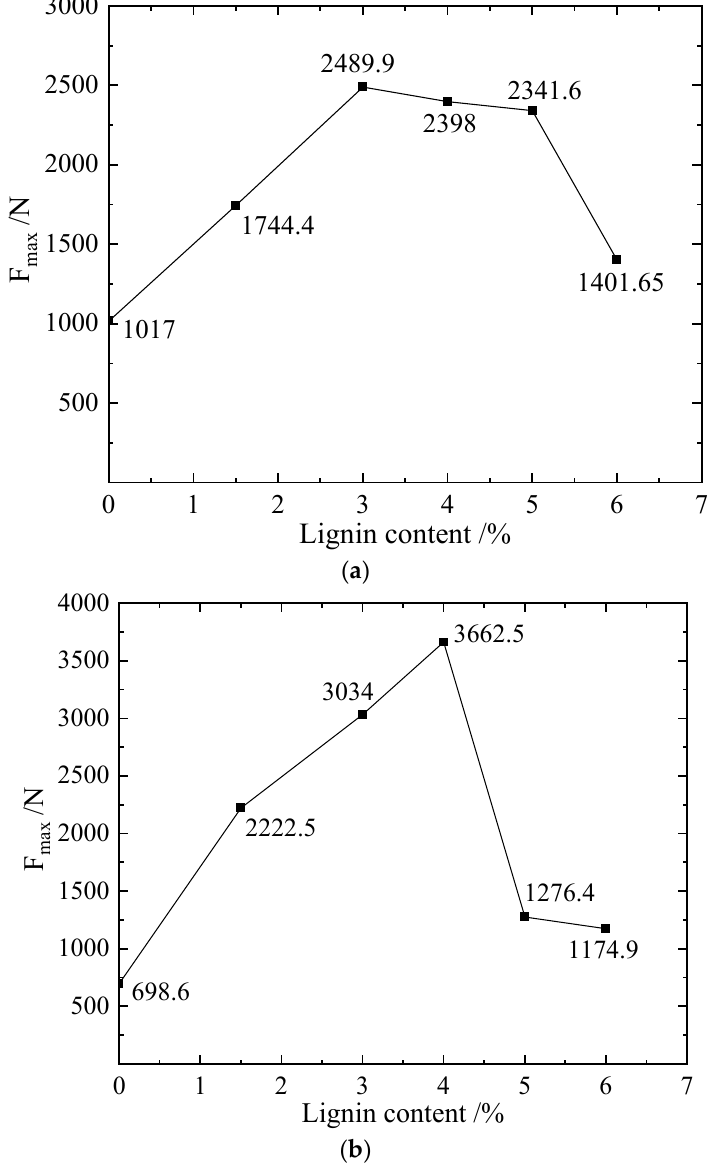
Figure 3. Maximum bearing capacity F max and lignin content of different samples in L scheme. ( a ) Diagram of maximum bearing capacity F max and lignin content of constant humidity sample in Scheme L. ( b ) F max and lignin addition ratio of solution L soaking sample.